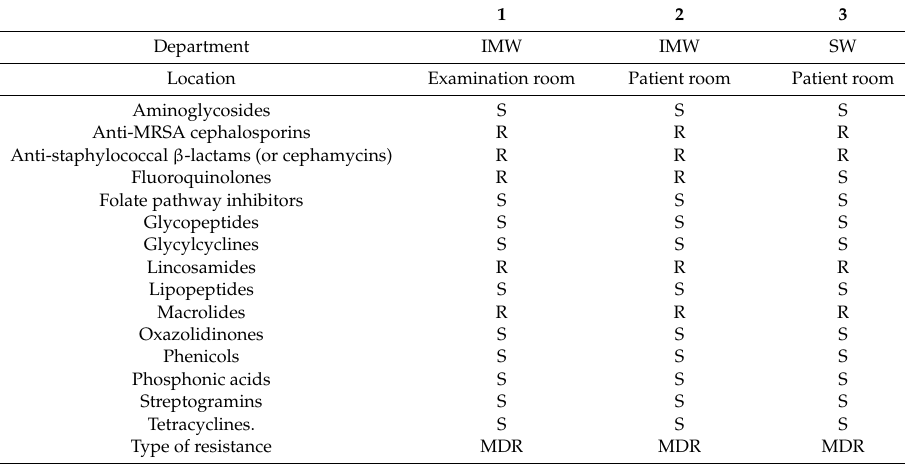
Table 6. Results of Sensitivity Tests for MDR St.